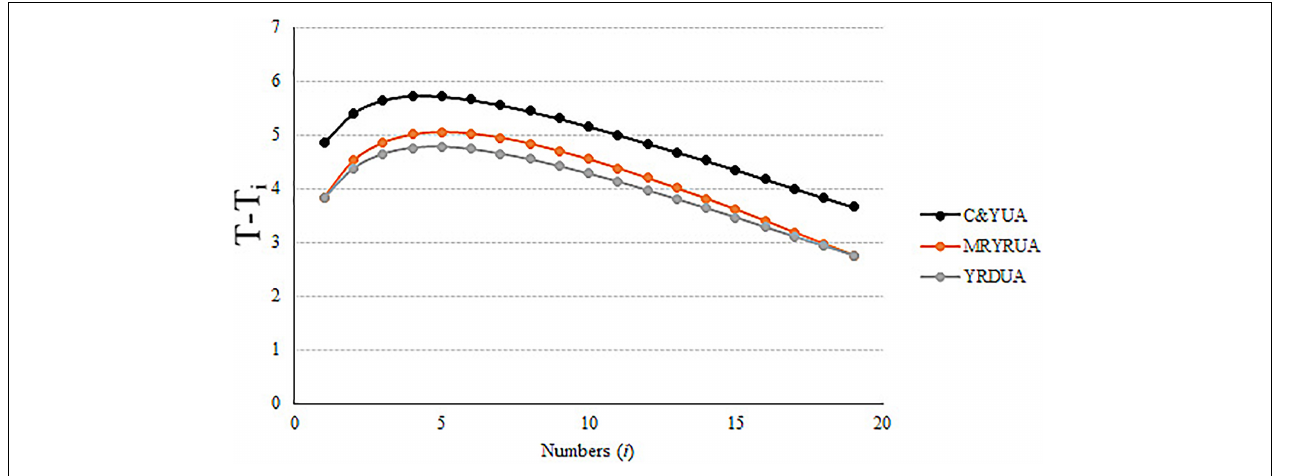
FIGURE 2 | Statistical differences corresponding to each number of i